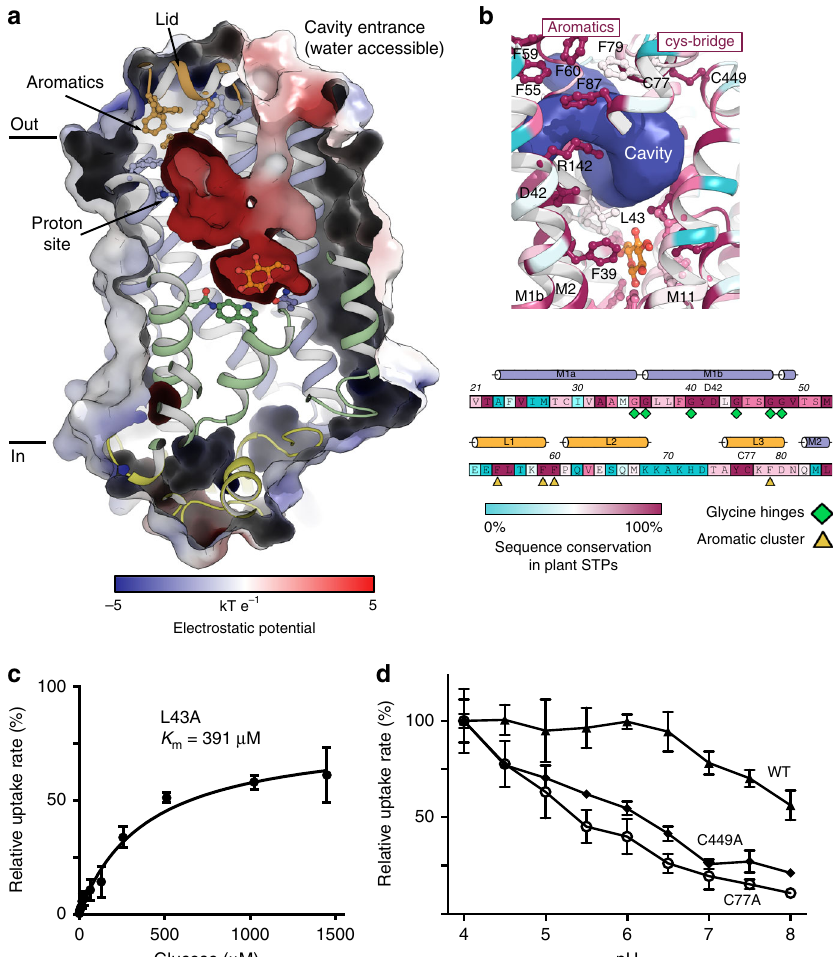
Fig. 3 The Lid domain and its effect on transport. a Electrostatic surface representation showing the negative cavity that connects the proton donor/ acceptor site with the glucose binding site. A cluster of aromatic residues on the Lid domain isolate the proton site from the extracellular side. b Conservation of the aromatic residues of the Lid domain and residues of the proton donor/acceptor site and M1b. Both structure and sequence is colored according to sequence conservation between 1336 unique STPs (35 – 95% seq. ID) found across plant species. c Michaelis-Menten fi t to glucose titration of STP10 mutant L43A at pH 4.0. d Glucose uptake rate as determined by a yeast uptake assay at different pH for WT STP10 and mutants C77A and C449A. Data for all assays are mean ± SD of three or more replicate